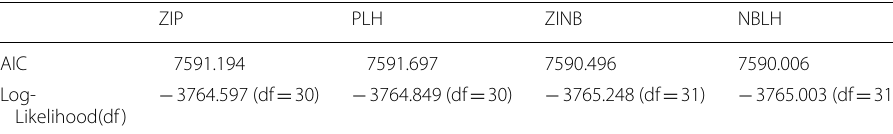
Table 2 Model comparison using AIC and log-likelihood ZIP